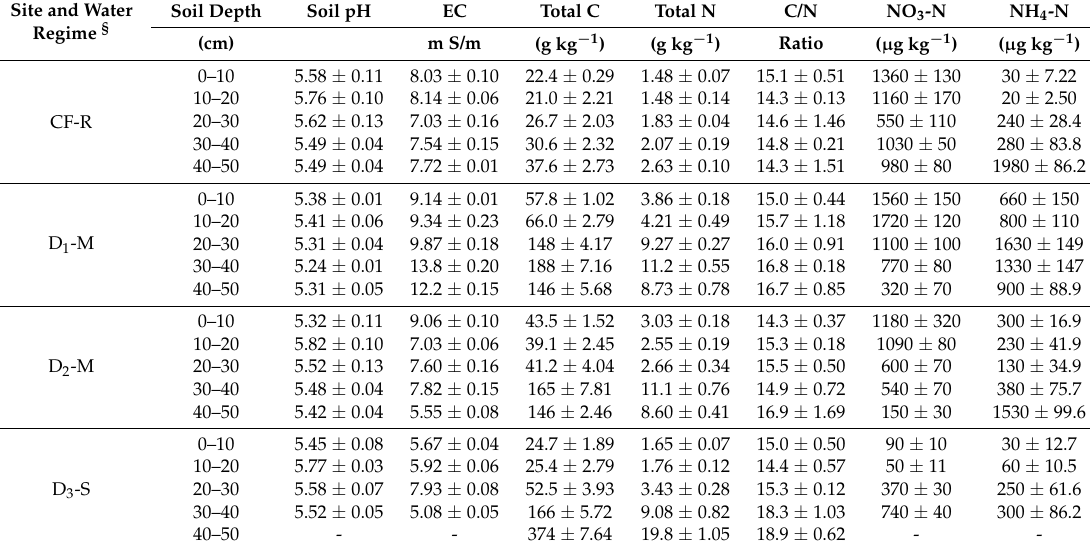
D 3 -S (drainage-single).